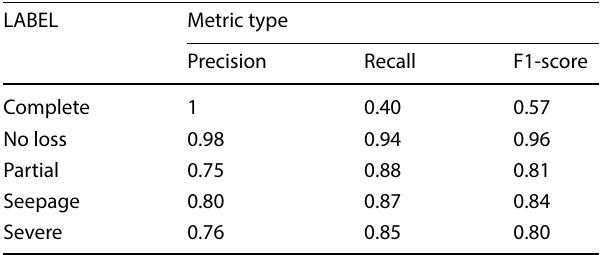
Table 8 Performance measurements achieved by the GRU model for the testing subset of data records